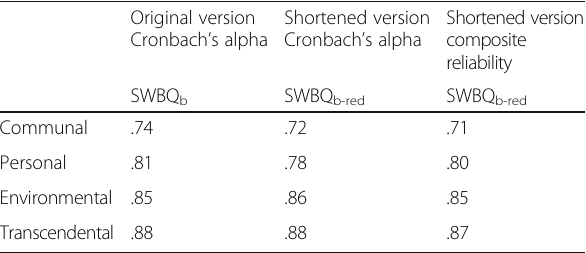
Table 5 Average variance extracted, square root of AVE